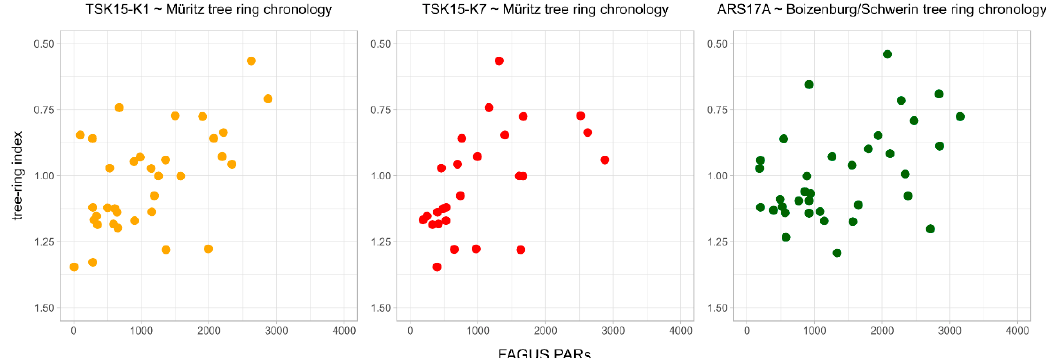
Figure 6. Scatter plots of tree-ring width in the Müritz and Boizenburg / Schwerin composite chronologies over annual F AGUS PARs.